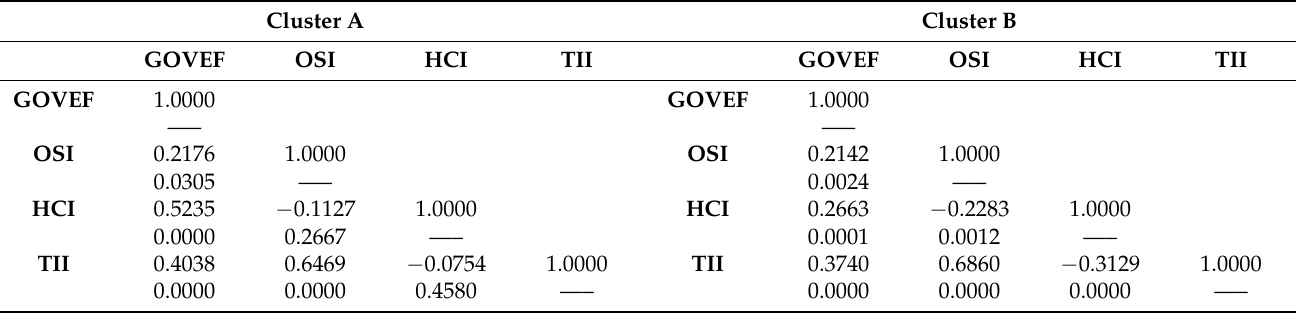
Table 5. Correlation matrix.